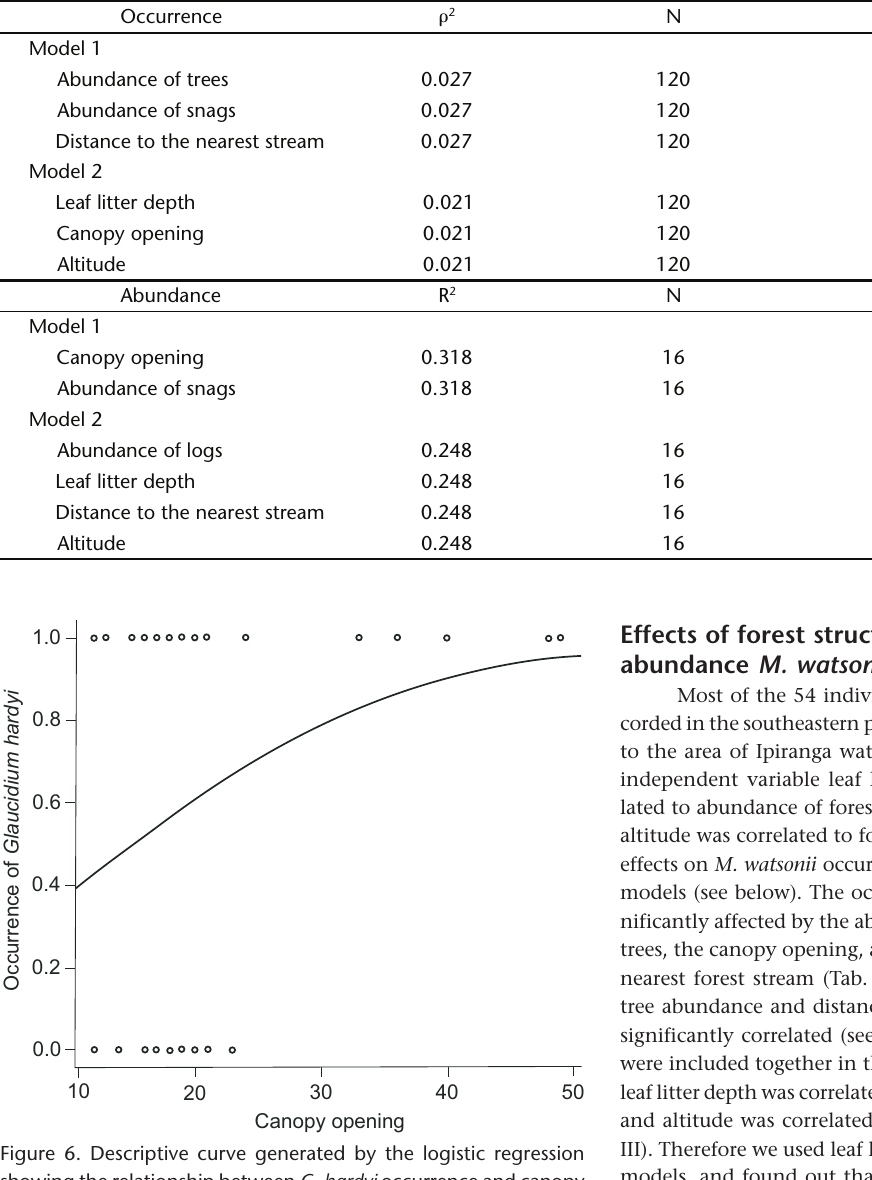
two separated simple linear regression models to evaluate their effects on G. hardyi abundance. None of them influenced the abundance of G. hardyi (tree abundance, r 2 = 0.171, N = 17, p = 0.099; distance to the nearest stream, r 2 = 0.057, N = 16, p = 0.356).